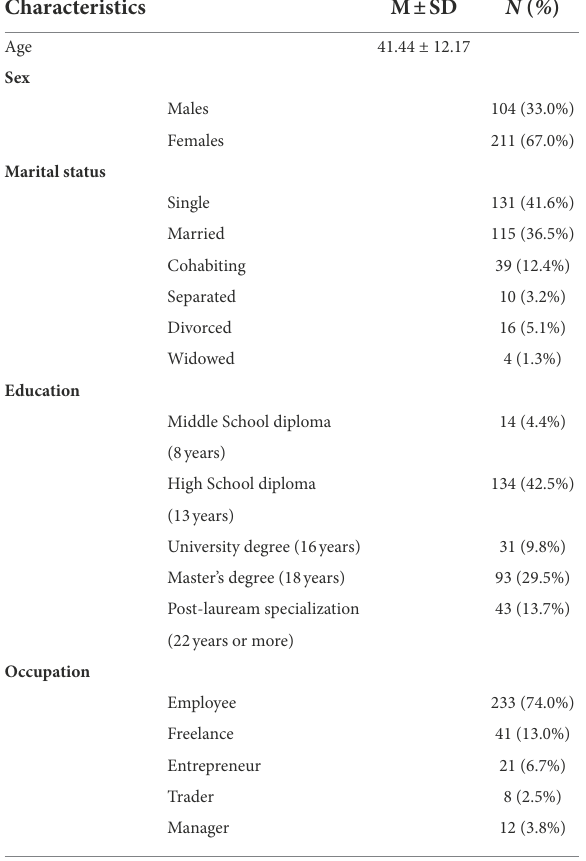
TABLE 1 Sociodemographic information of the 315 workers involved in the research. Characteristics